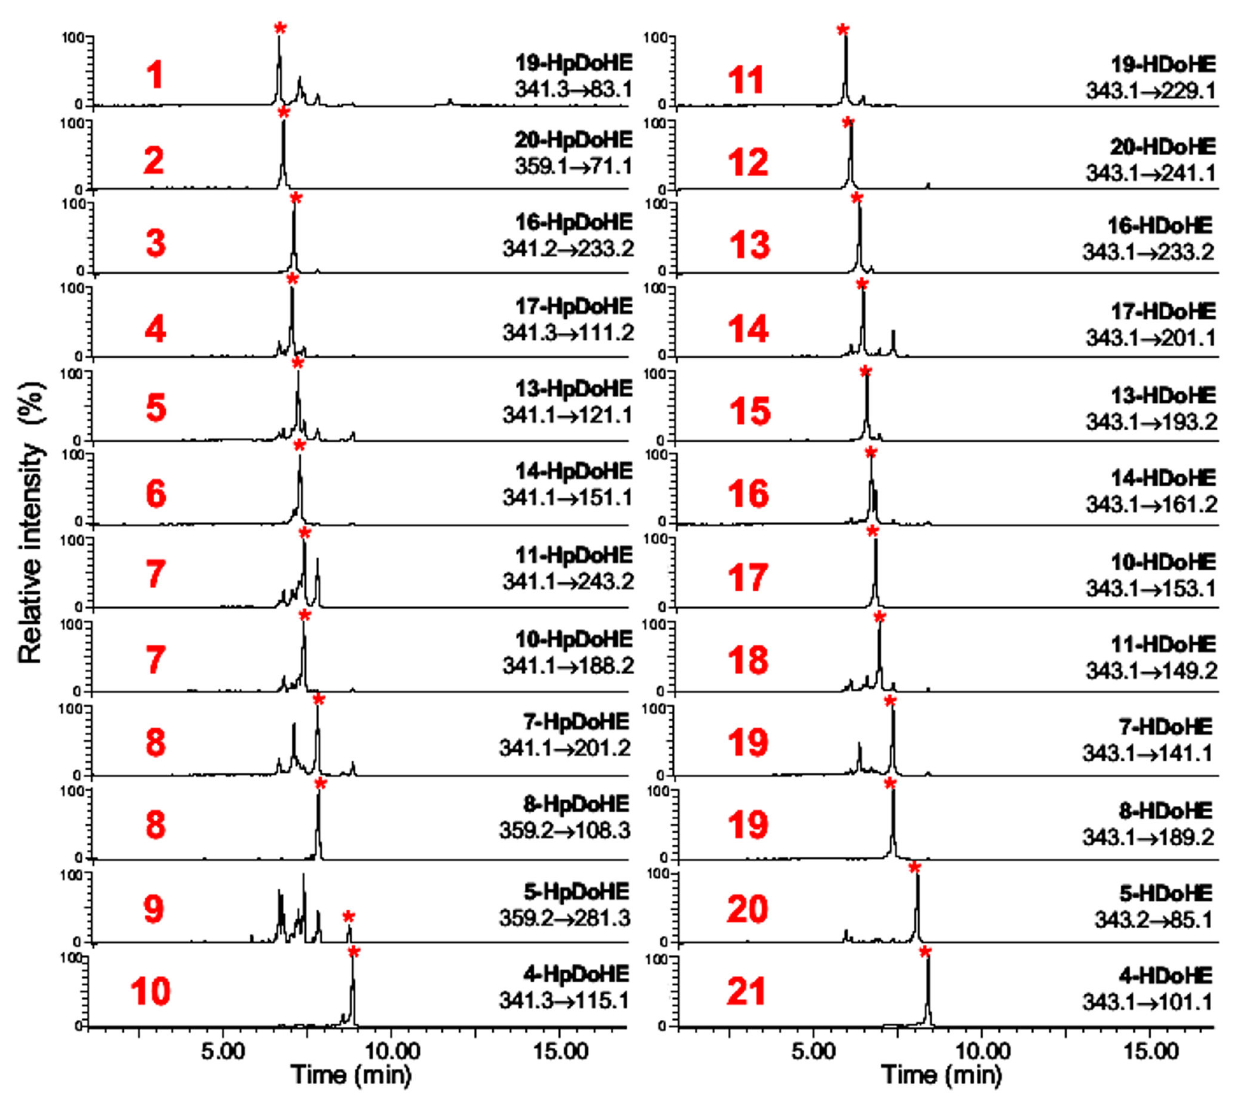
Figure 5. Representative chromatograms of individual SRM transitions selected for each HpDoHE and HDoHE isomer. The numbers in red correspond to the peaks observed in the LC-MS analysis (Figure 2).